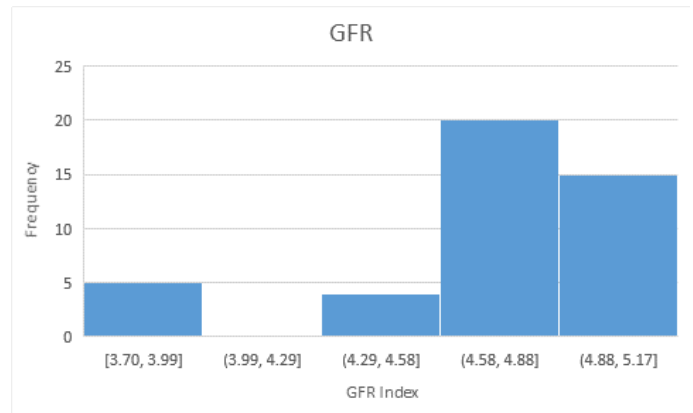
Figure 18. Histogram of DRASTIC Index values. ISPRS Int. J. Geo-Inf. 2018 , 7 , x FOR PEER REVIEW 22 of 28